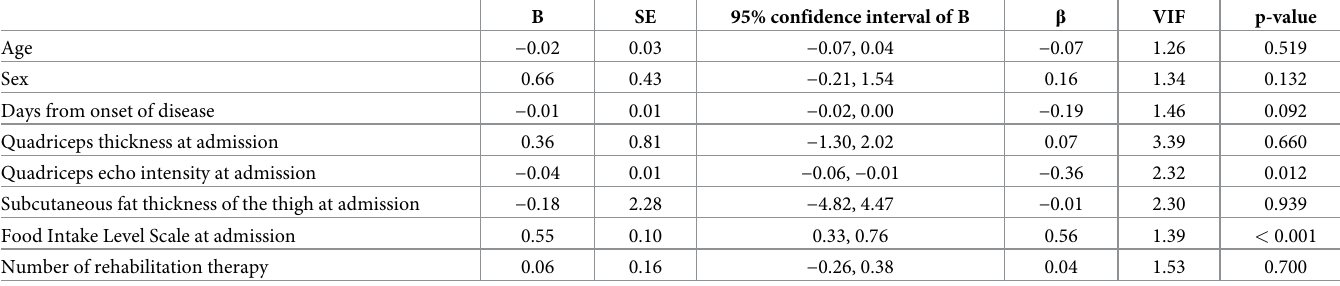
Table 3. Multiple regression analysis for Food Intake Level Scale at discharge.